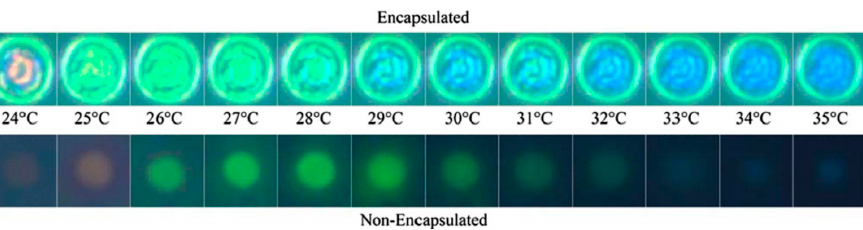
Figure 9. Raw color images of encapsulated TLC particles (top) and non-encapsulated TLC particles (bottom) at various temperatures, obtained by Segura et al. [ 76 ] . Article published with open access.